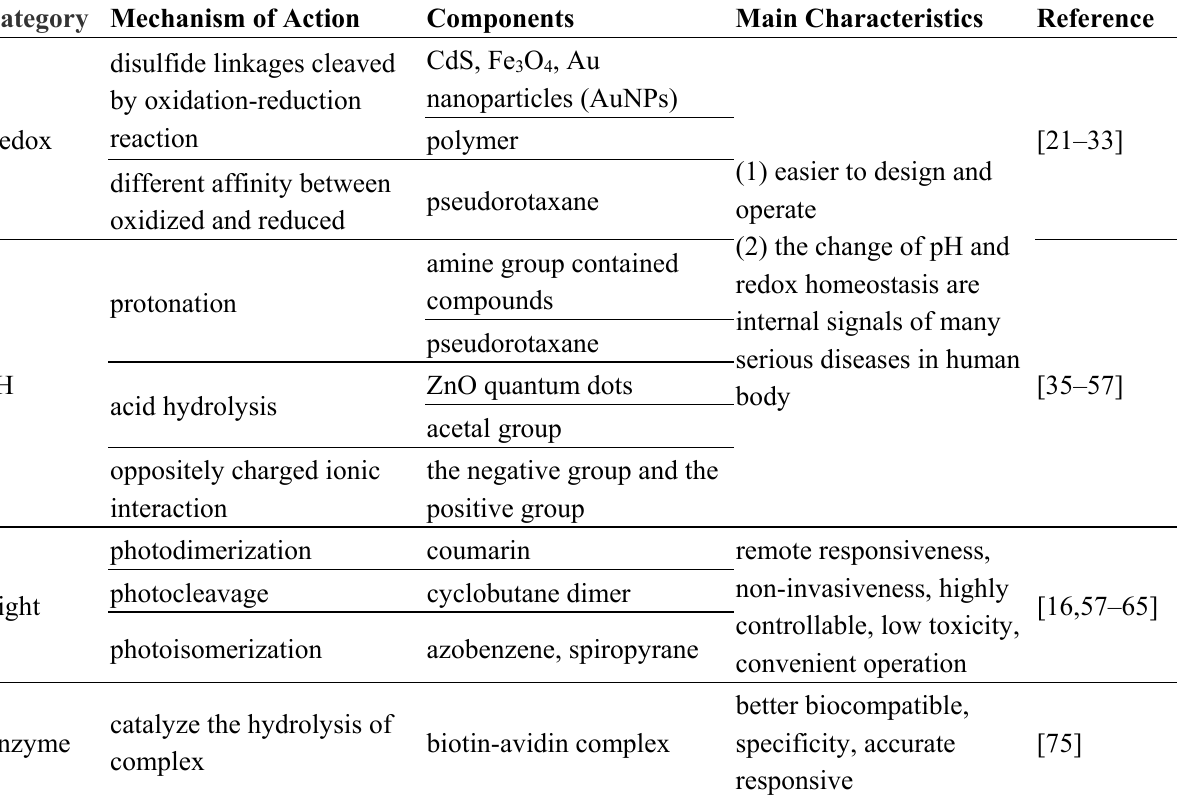
Table 1. Summary of functionalized MSN-based controlled